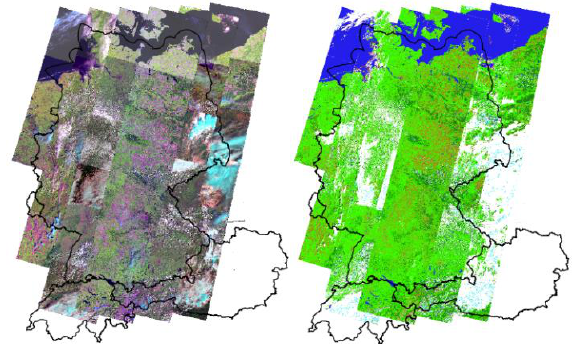
Figure 4. Landsat mosaic and derived pre-classification for Germany in a time window of 5 weeks in summer 2014 This configuration delivers atmospheric corrected scenes, pre- classification and Green Leaf Area Index for 40 scenes or the complete coverage of Germany in only 33 minutes. Taking the processing of two scenes at the same time on the desktop solution, the results would be ready in 5:20 hours.